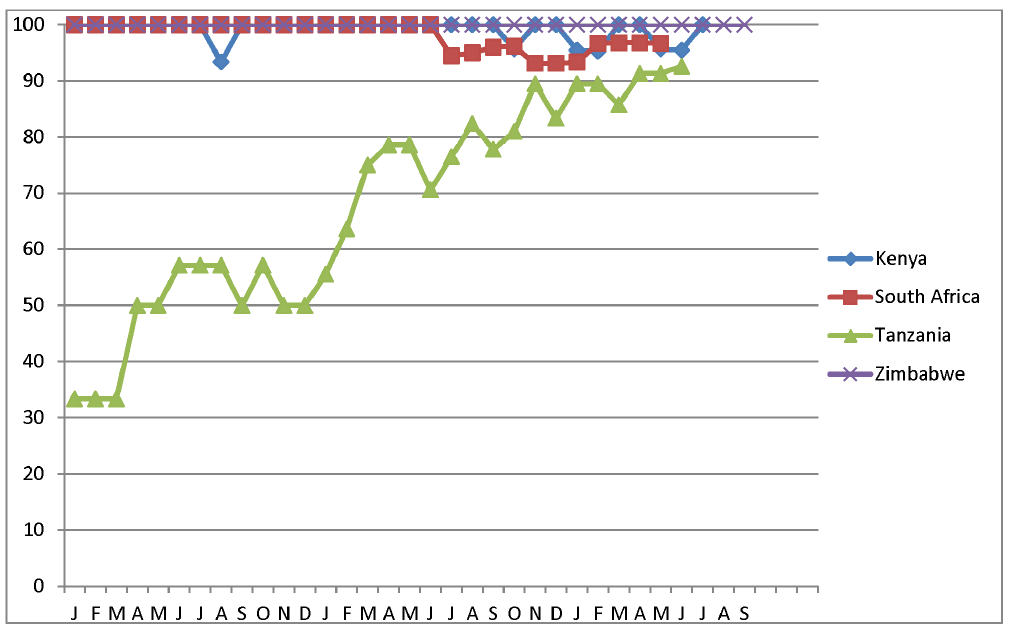
Figure 4. Proportion of VMMC sites by month and by country using forceps-guided method, January 2010 –mid-2012. The number of sites on which these data are based varies markedly by month over the observation period, as shown in Figure 1.